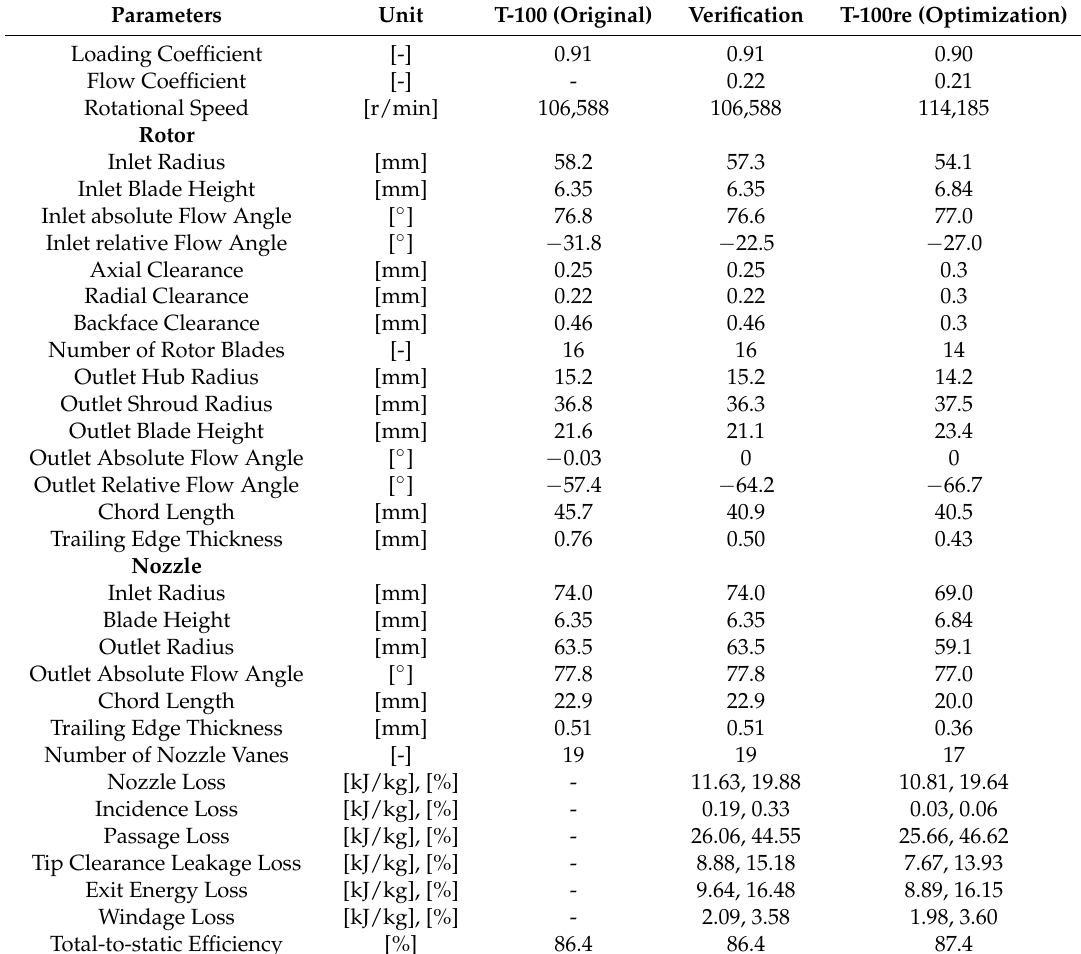
Table 3. Results of the validation design and optimization